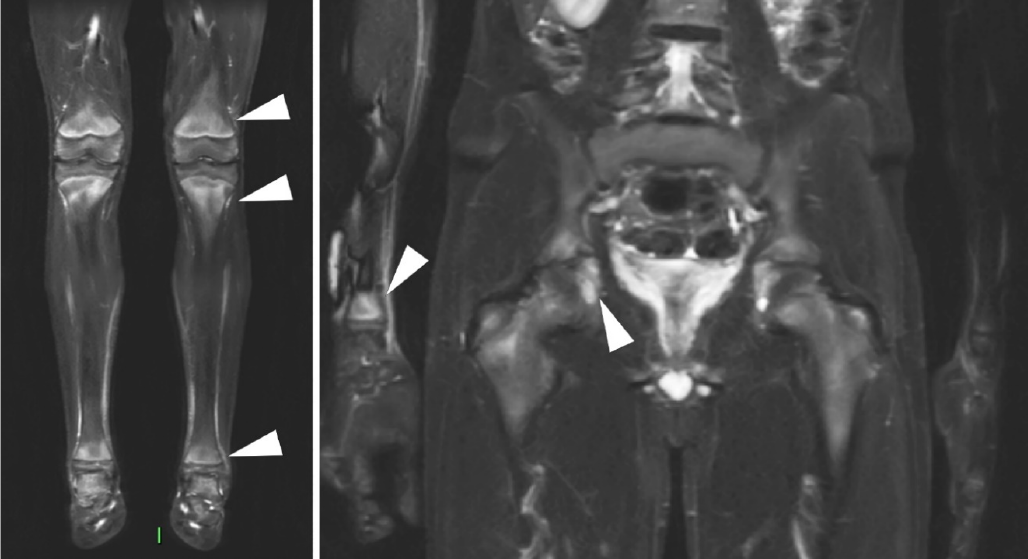
Figure 5. MRI in CRMO. Coronal T2 weighted with fat saturation images of a whole-body MRI in a 12 year old boy with chronic recurrent multifocal osteomyelitis (CRMO). There is evidence of bilateral bone marrow edema in the distal femur, distal / proximal tibia and talus, triradiate cartilage, and unilateral BME on the right distal radius (indicated by arrowheads. In the case of bilateral lesions, only one side was annotated).